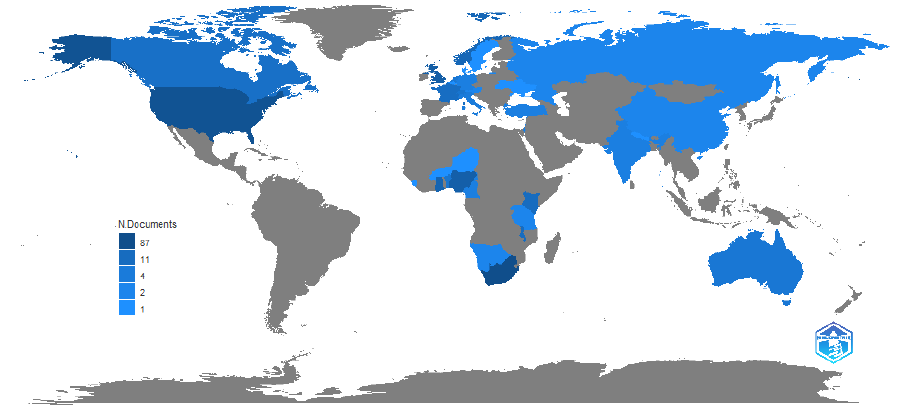
Figure 3. Scientific production per country. Source: Author’s own, based on Web of Science search. The most influential countries were South Africa, the United States, France, Norway and Ghana. Only 4 of the top 10 countries shown in Table 5 were African, again pointing to a dearth of African scholarship in the area. Where research is conducted, these often attract high citation rates, suggesting that researchers are reliant on a small number of articles for local knowledge of the study area. This suggests the need for a far broader range of local-based information. Table 5. Most cited countries.